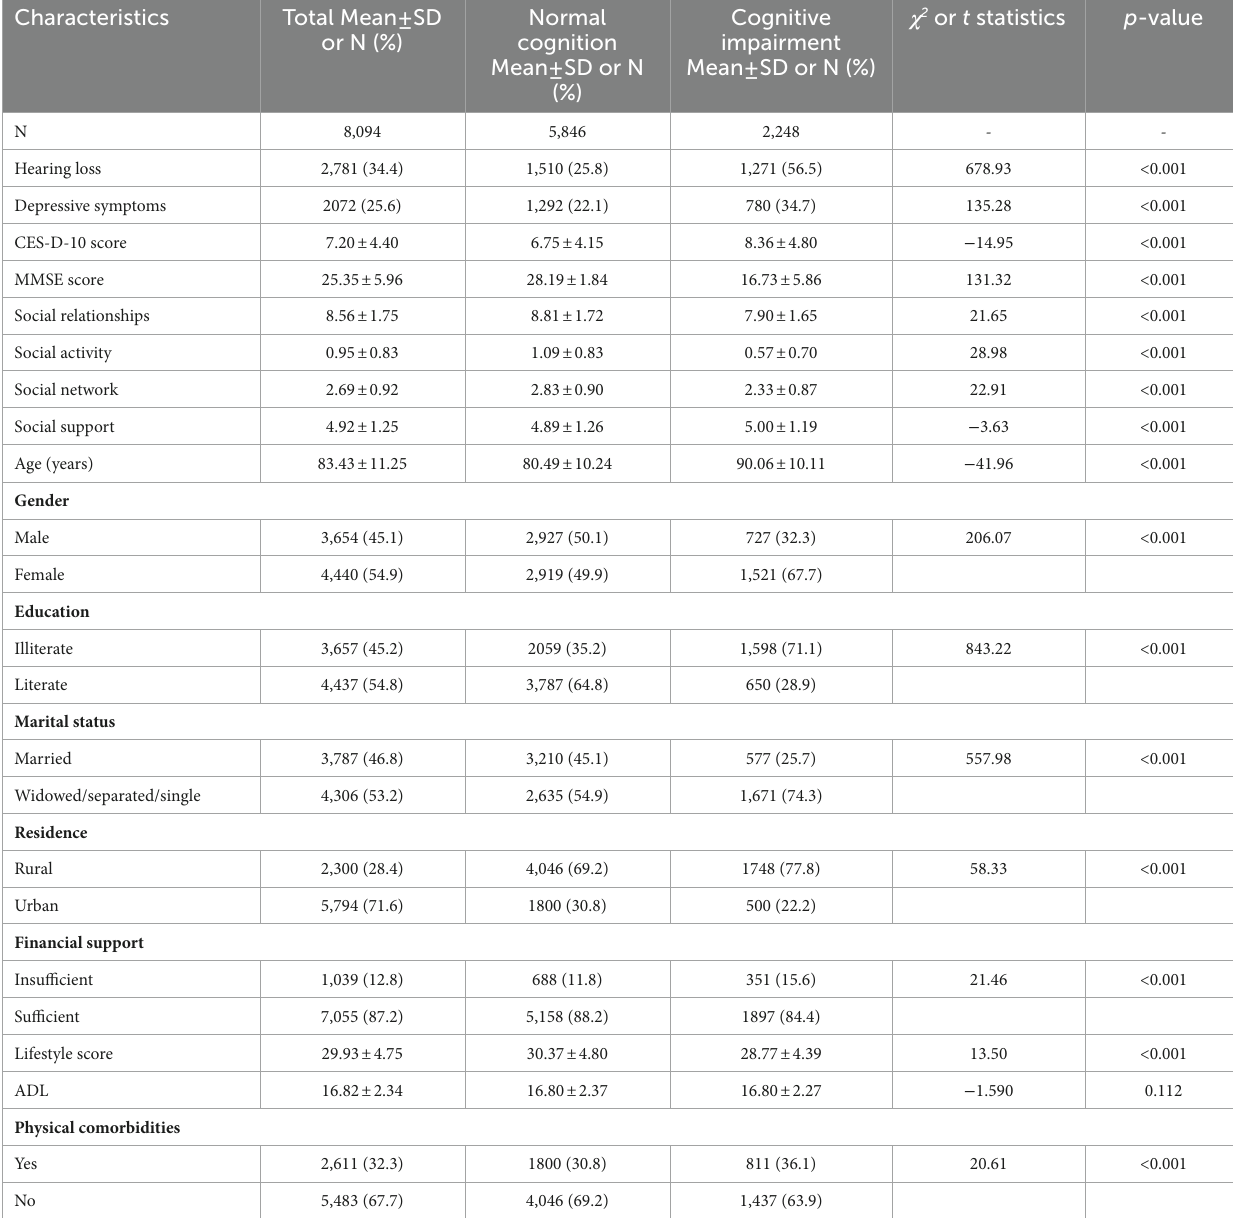
TABLE 1 Characteristics of the sample stratified by cognitive